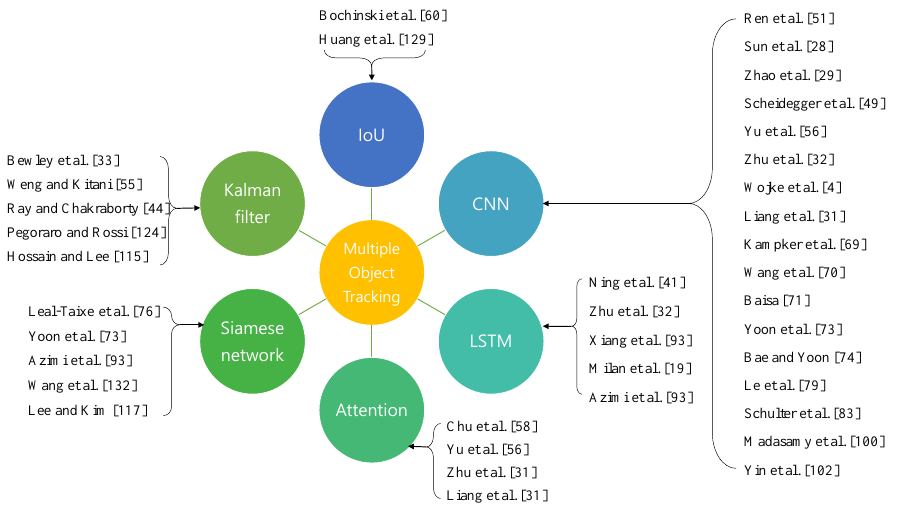
Figure 17. The categorization of MOT algorithms into six main categories, IoU, CNN, LSTM, attention, Siamese network, and Kalman